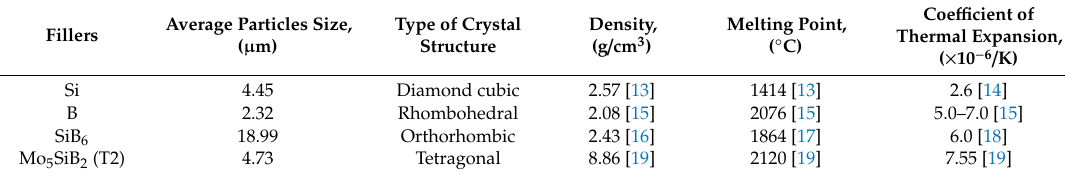
Table 1. Some properties of filler